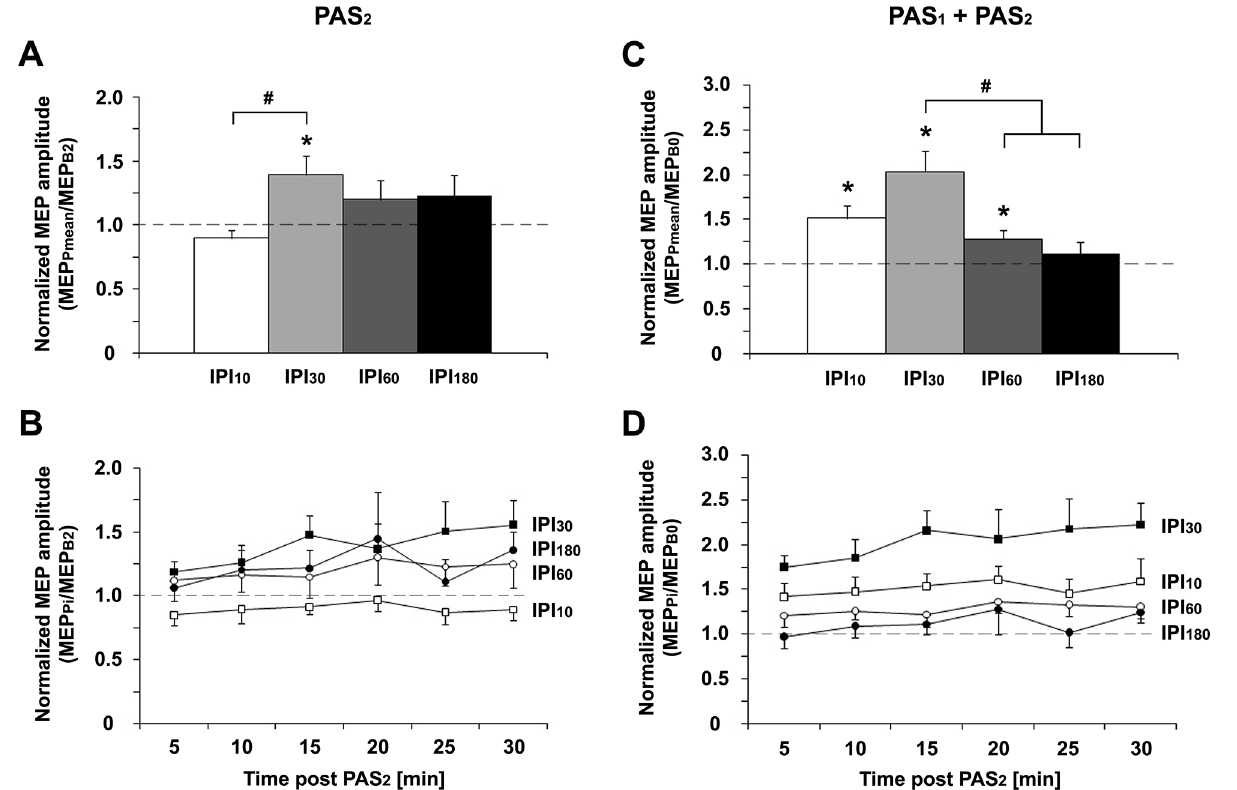
Fig 3. PAS 2 -induced increases in MEP amplitude after PAS 1 -priming. A : The PAS 2 -induced increase in MEP amplitude after PAS 1 -priming (MEP Pmean / MEP B2 ) was significantly higher at IPI 30 than IPI 10 (#, P < 0.05; paired two-tailed t test). B : Time course of MEP Pi /MEP B2 (i = 1,2, ... ,6) over 30min after PAS 2 for IPI 10 (open squares), IPI 30 (filled squares), IPI 60 (open circles), and IPI 180 (filled circles). C : The cumulative effect of PAS 1 and PAS 2 on MEP amplitudes (MEP Pmean /MEP B0 ) was significantly higher for IPI 30 than for IPI 60 and IPI 180 (#, P < 0.05; paired two-tailed t tests), and showed a trend to be higher for IPI 30 vs. IPI 10 ( P = 0.095; paired two-tailed t test). D : Time course of MEP Pi /MEP B2 (i = 1,2, ... ,6) over 30min after PAS 2 for IPI 10 (open squares), IPI 30 (filled squares), IPI 60 (open circles), and IPI 180 (filled circles). * , P < 0.05; one-sample two-tailed t tests. Data are means ± 1 SEM from twelve subjects.